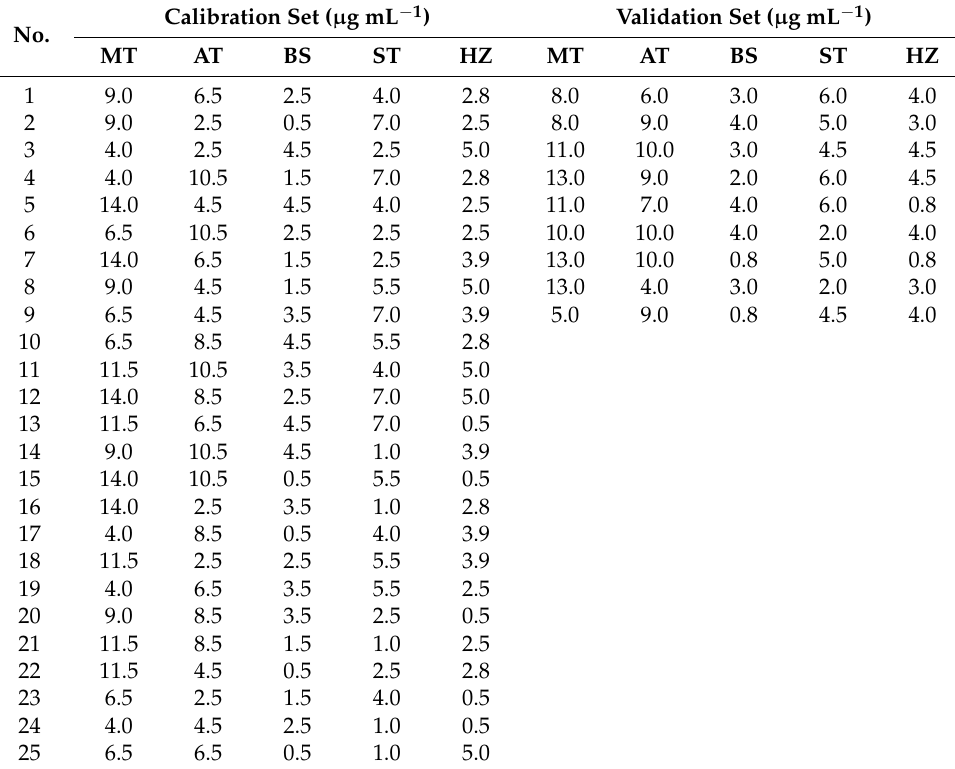
Table 1. The concentration matrix used for the calibration and validation sets of the studied